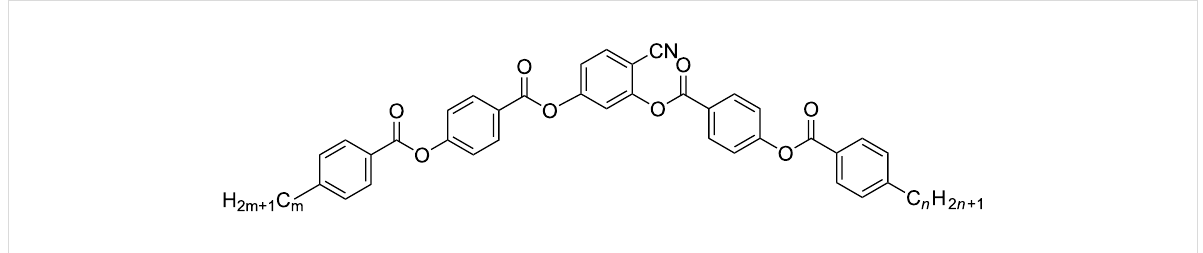
Figure 1: The molecular structure and phase transitions of two bent-core liquid crystal samples: BCN66 ( m = n = 6): Cr 55 °C [37.1] N cybC 101 °C [0.5] Iso [52] and BCN84 ( m = 8, n = 4): Cr 62 °C N cybC 96 °C Iso [51]. The transition temperatures were obtained on cooling under quasi-equilibrium conditions at a rate of ≈ 1 K min − 1 , Δ H was taken from DSC upon cooling (10 K min − 1